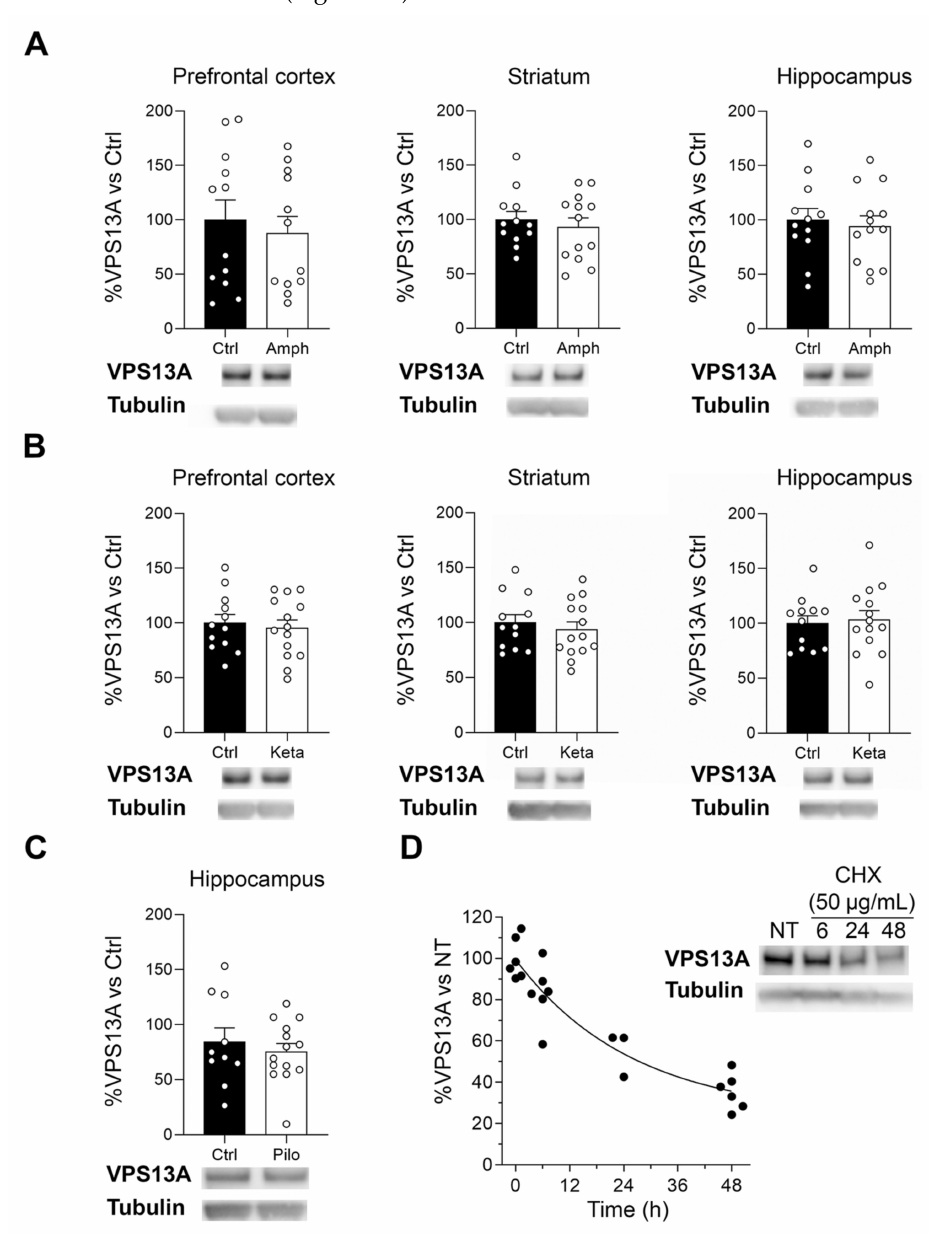
Figure 7. VPS13A protein concentration is not modulated by dopaminergic, glutamatergic, or cholinergic systems. VPS13A levels were analyzed by Western blot in the prefrontal cortex, striatum, and hippocampus of an adult mouse treated with ( A ) D-amphetamine (3 mg/kg, i.p., 8 days, n = 12–13), ( B ) ketamine (30 mg/kg, i.p., 8 days, n = 12–14) or ( C ) pilocarpine (45 mg/kg, i.p., single dose, n = 10–12). Tubulin was used as a loading control. Data represent mean ± SEM and differences were analyzed by Student’s t -test. ( D ) Cultured cells of the STHdh Q7/Q7 cell line were treated with cycloheximide (CHX, 50 µ g/mL) for 6, 24, and 48 h. Levels of VPS13A were then analyzed by Western blot. Tubulin was used as a loading control. Data represent mean ± SEM. The VPS13A half-life was calculated by fitting the curve to a one-phase decay type exponential equation. R 2 =